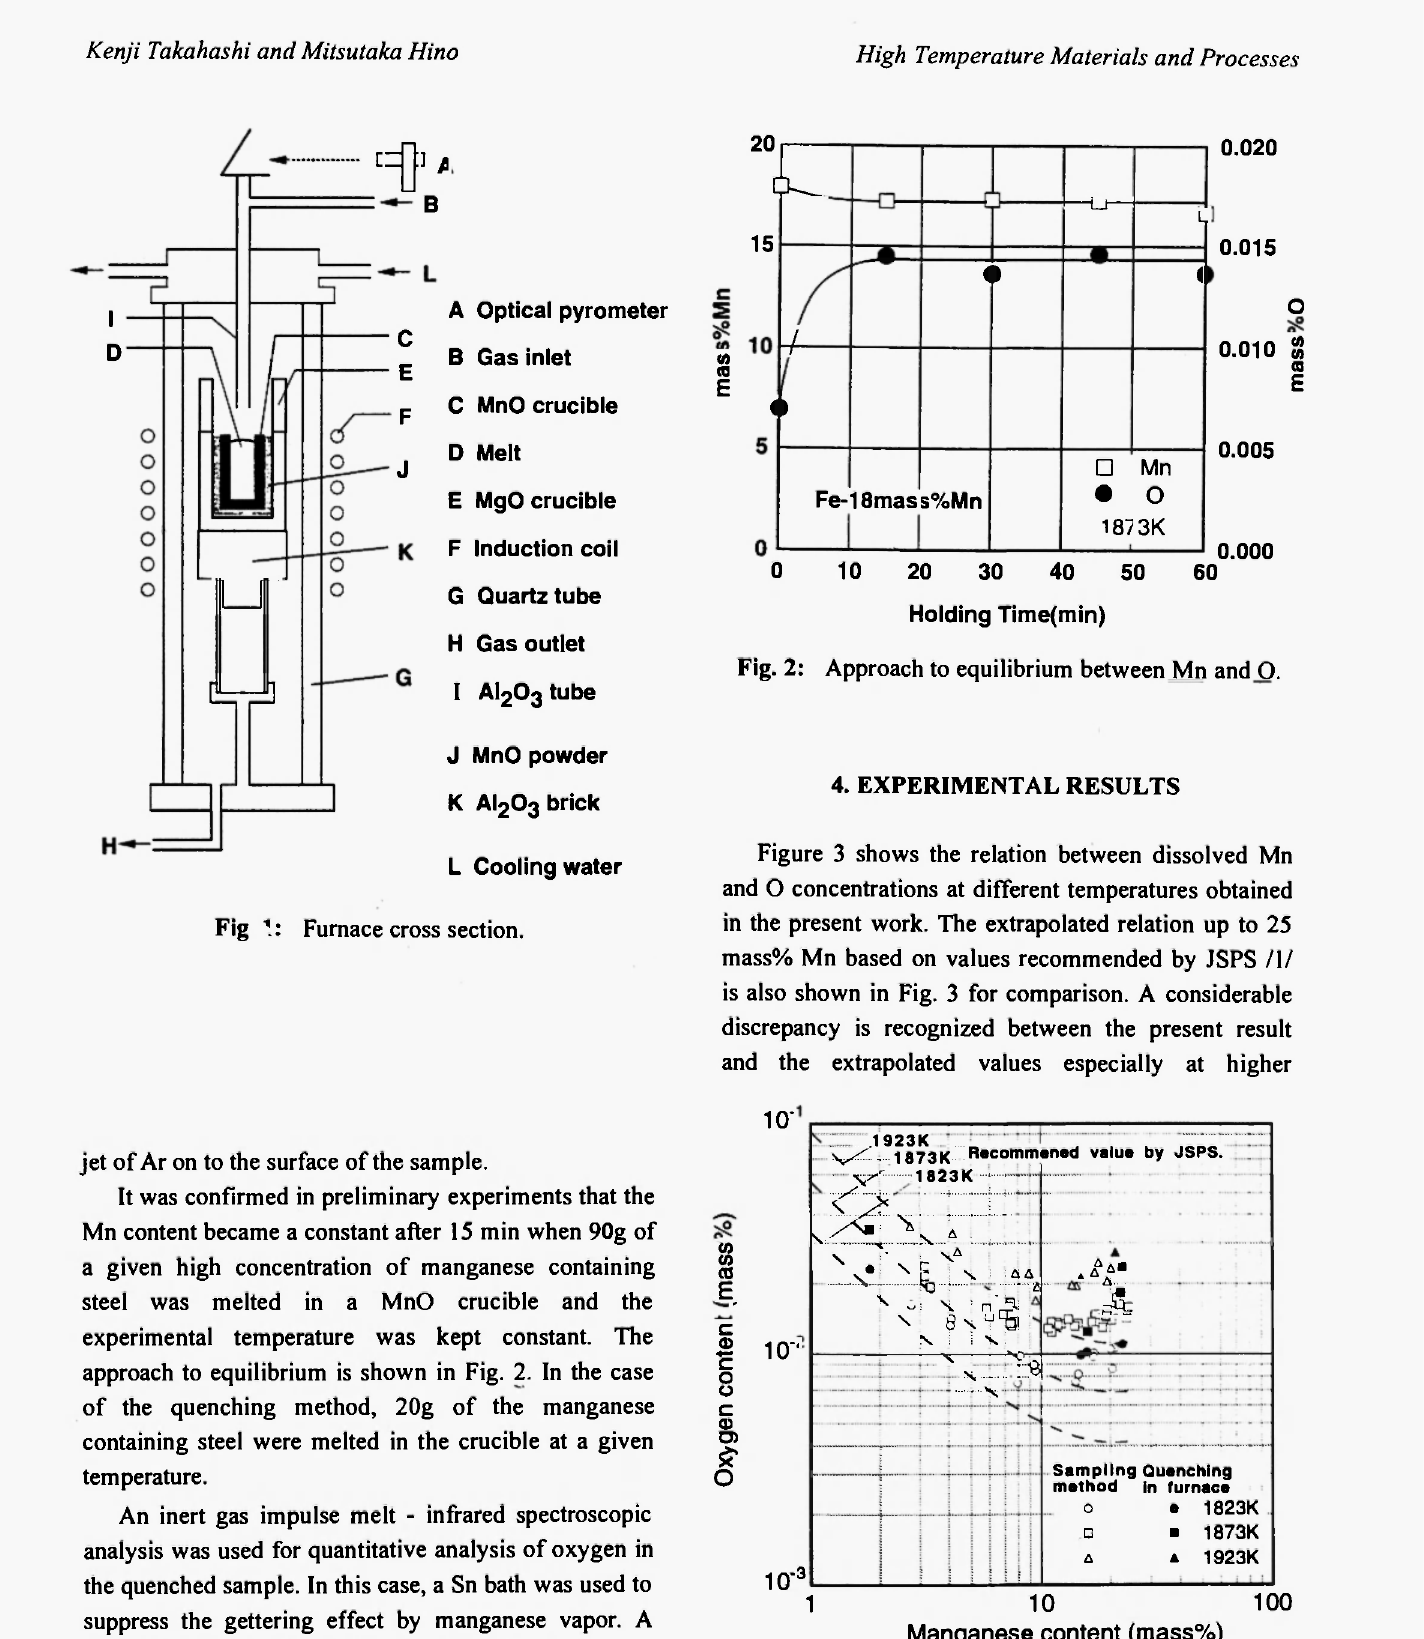
Fig. 3: Relation between [%Mn] and [%0] in liquid